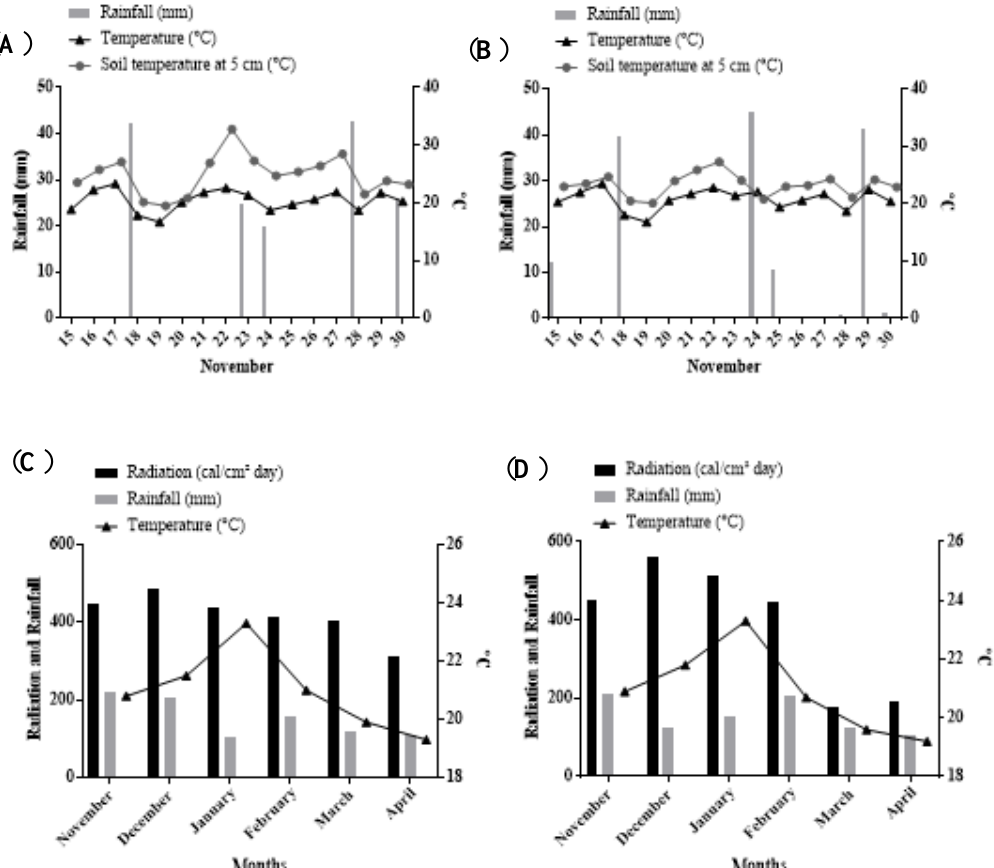
Figure 1. Climate date. Rainfall (mm), average temperature of air ( ◦ C), and average temperature of soil at 5 cm ( ◦ C) near the sowing at ( A ) site I, ( B ) site II and III. Rainfall (mm), radiation (calories / cm 2 · day − 1 ), and average temperature of air ( ◦ C) during the cycle of the crop at ( C ) site I, ( D ) site II and III. Source: Instituto Nacional de Meterologia